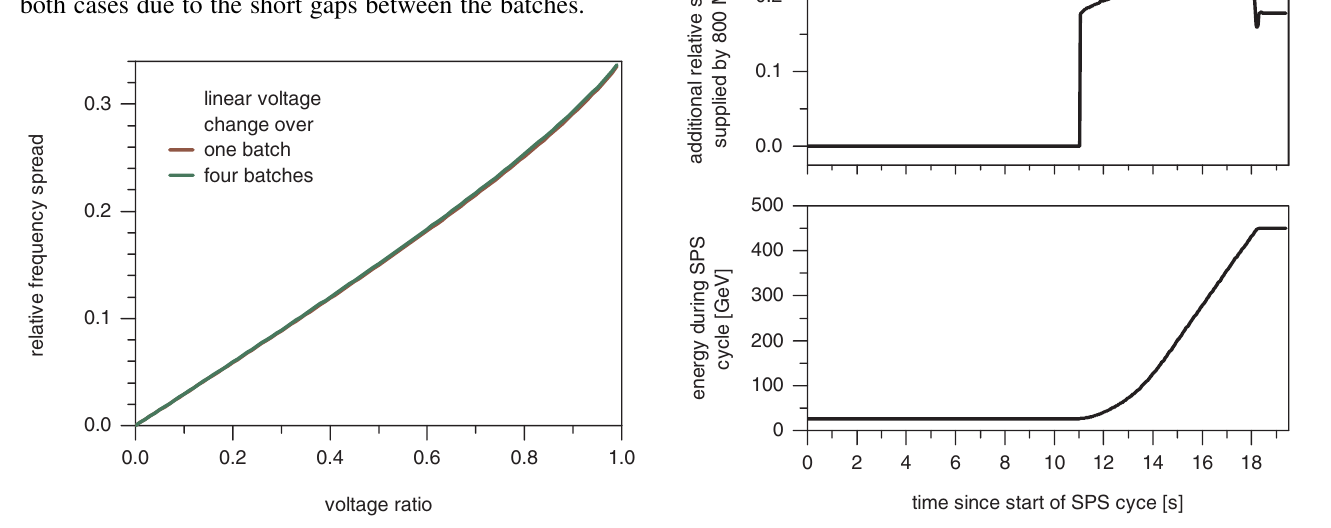
FIG. 1. (Color) Dependence of the relative synchrotron fre- quency spread in case of one and four batches in the SPS.